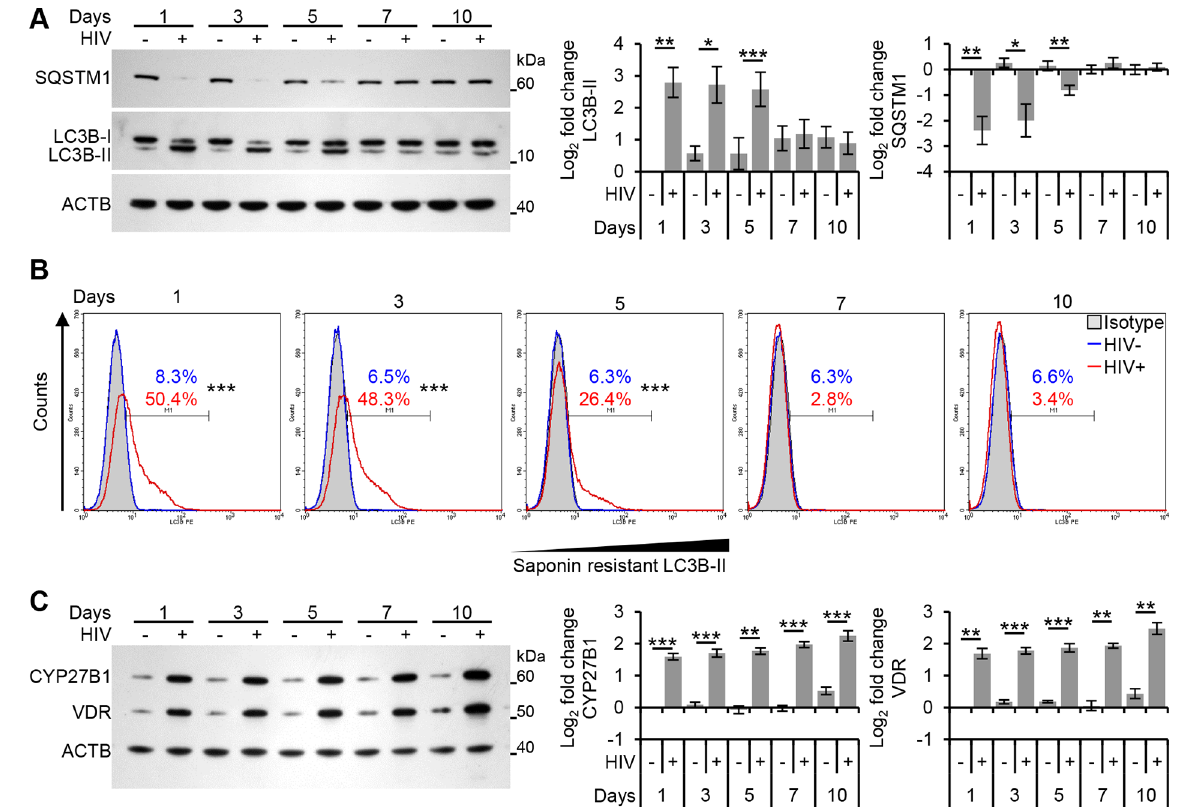
Fig 3. Autophagy is decreased at later time points post-infection in human macrophages. Macrophages were infected with HIV and cells harvested at 1, 3, 5, 7, and 10 days post-infection. (A) Cells were analyzed for endogenous LC3B and SQSTM1 by Western blotting. Left , a representative blot is shown. Right , densitometric analysis of immunoblots from independent donors presented as means ± s.e.m., n = 6. (B) Cells were harvested then subjected to flow cytometry analysis of saponin-resistant LC3B-II in macrophages. Representative histograms of cells displaying saponin-resistant LC3B-II are shown. (C) Cells were harvested, lysed then analyzed for CYP27B1 and VDR by Western blotting. Left , a representative blot is shown. Right , densitometric analysis of immunoblots from independent donors presented as means ± s.e.m., n = 6.